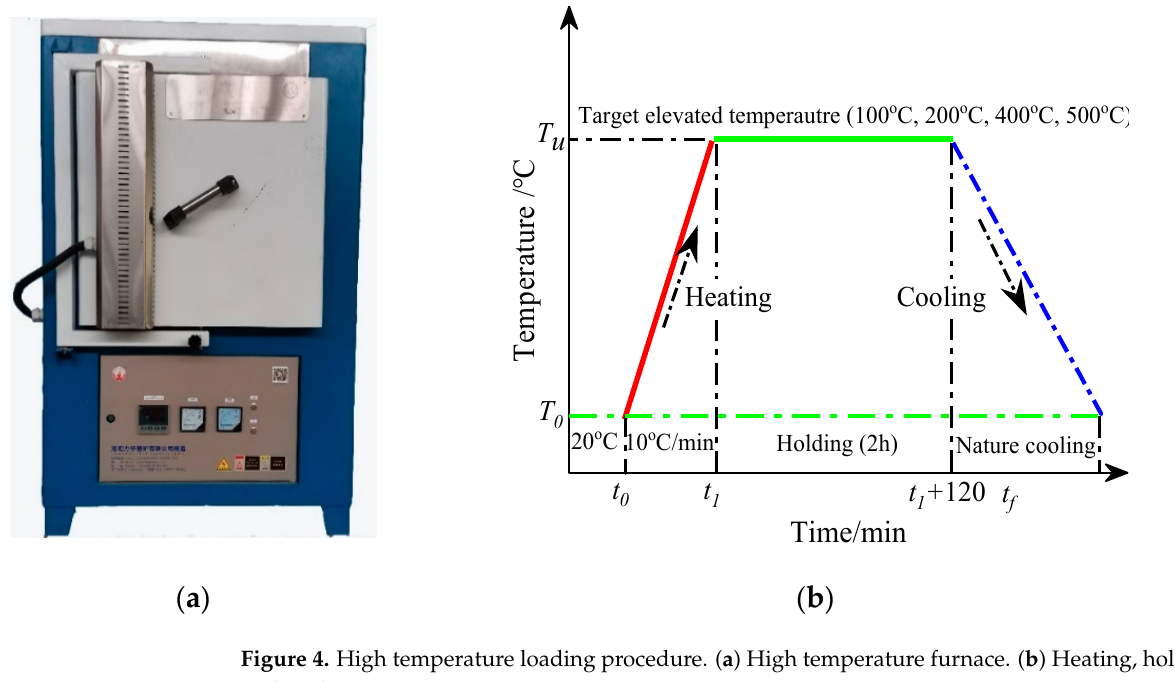
Figure 4. High temperature loading procedure. ( a ) High temperature furnace. ( b ) Heating, holding, and cooling process.